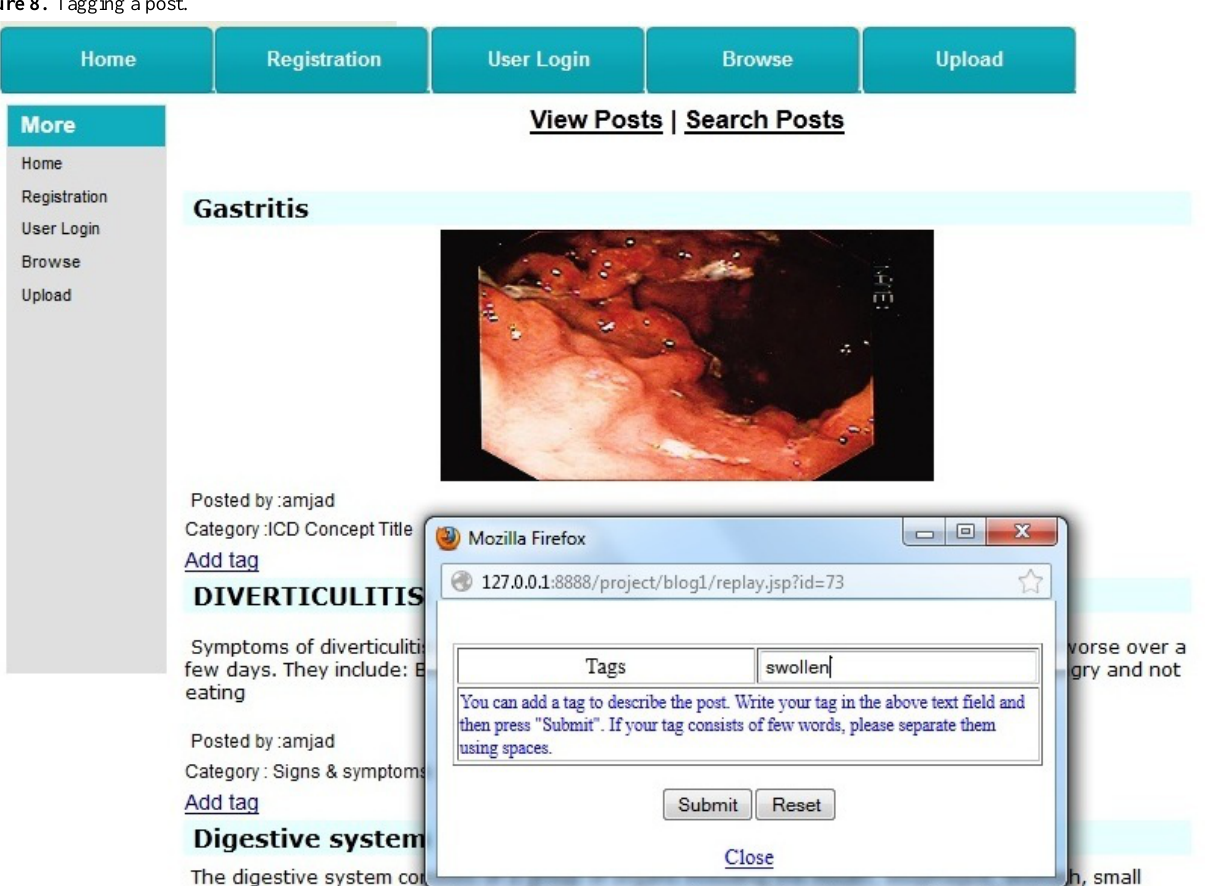
Figure 8. Tagging a post.